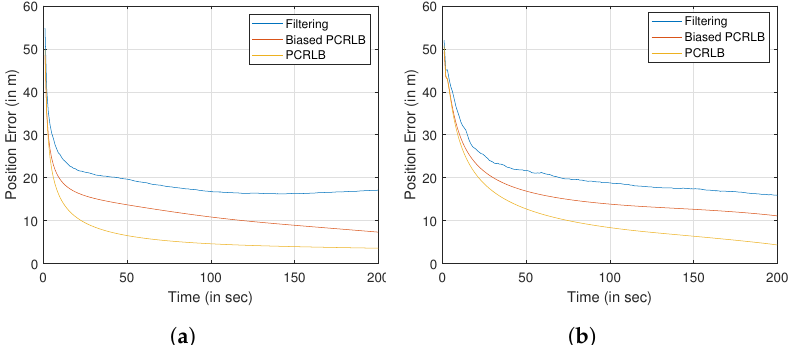
Figure 5. Comparison of the performance bounds. ( a ) Stationary ground target. ( b ) Mobile ground